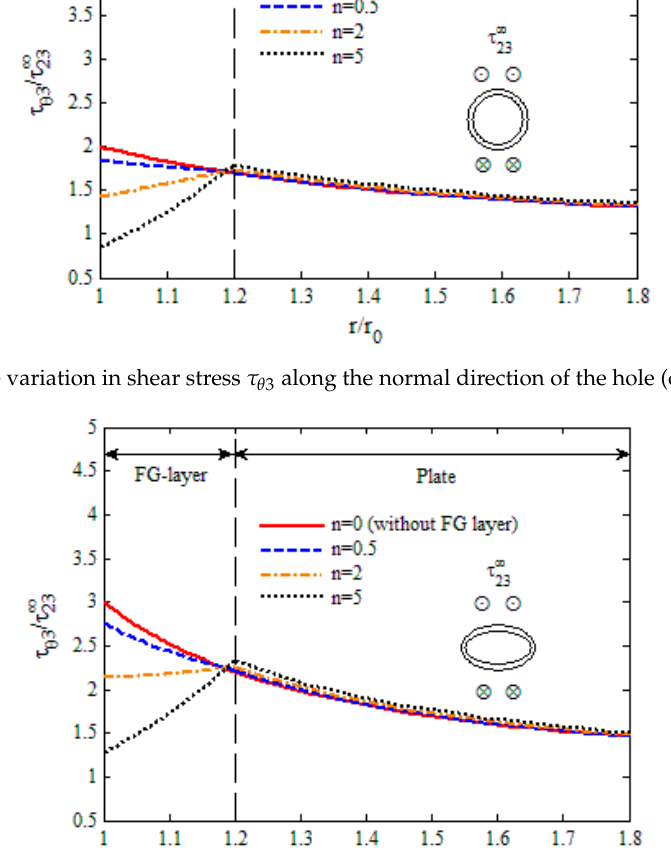
Figure 10. The variation in shear stress 3 θ τ along the normal direction of the hole (triangle, 0 δ= ).